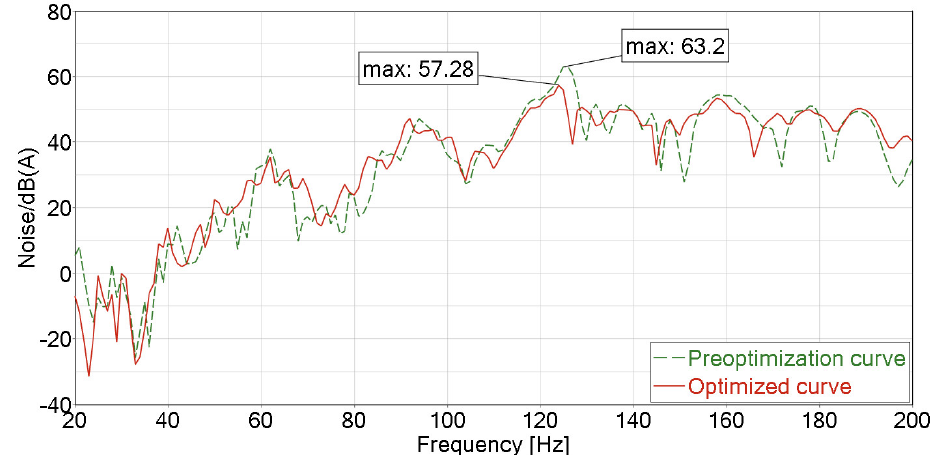
Figure 17. Left engine suspension X-direction NTF curve.